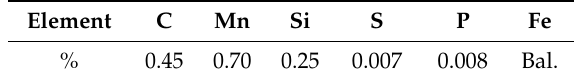
Table 1. Chemical composition of 1045 carbon steel rods (as-received condition).